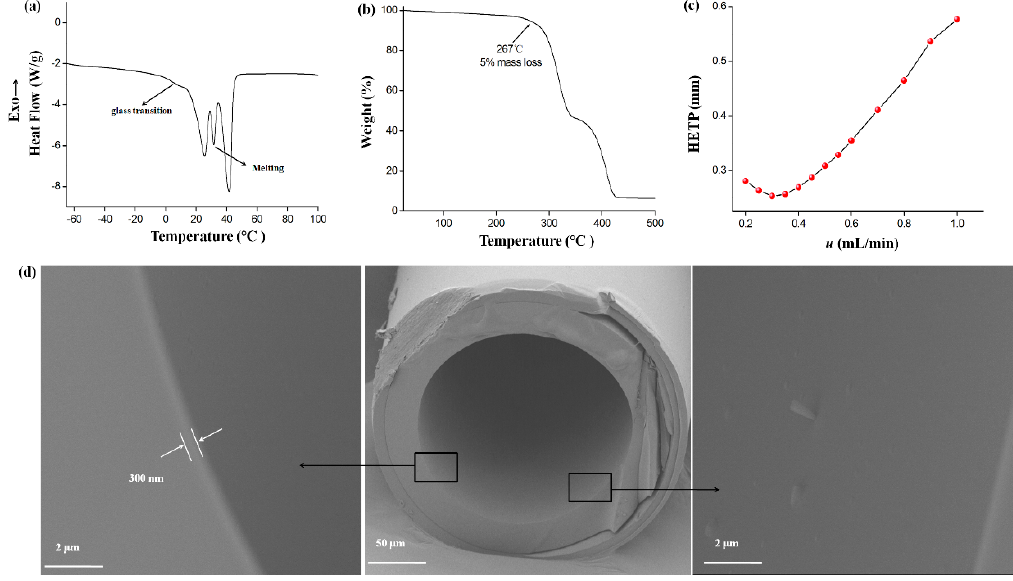
Figure 1. ( a ) Differential scanning calorimetry (DSC) curves of the PCL-PEG-PCL; ( b ) Thermogravimetric analysis (TGA) curve of the PCL-PEG-PCL; ( c ) Golay curve of the PCL-PEG-PCL column determined by n -dodecane at 120 °C;( d ) the cross-section scanning electron microscopy(SEM) images on the inner wall surface and the coating thickness of the PCL-PEG-PCL